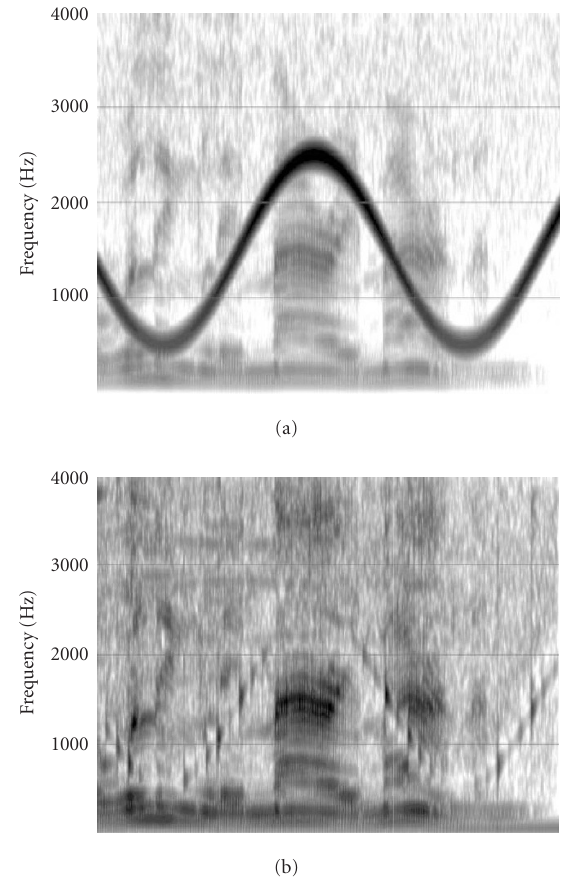
Figure 7: (a) The spectrogram of the extracted siren. (b) The spec- trogram of the extracted utterance.